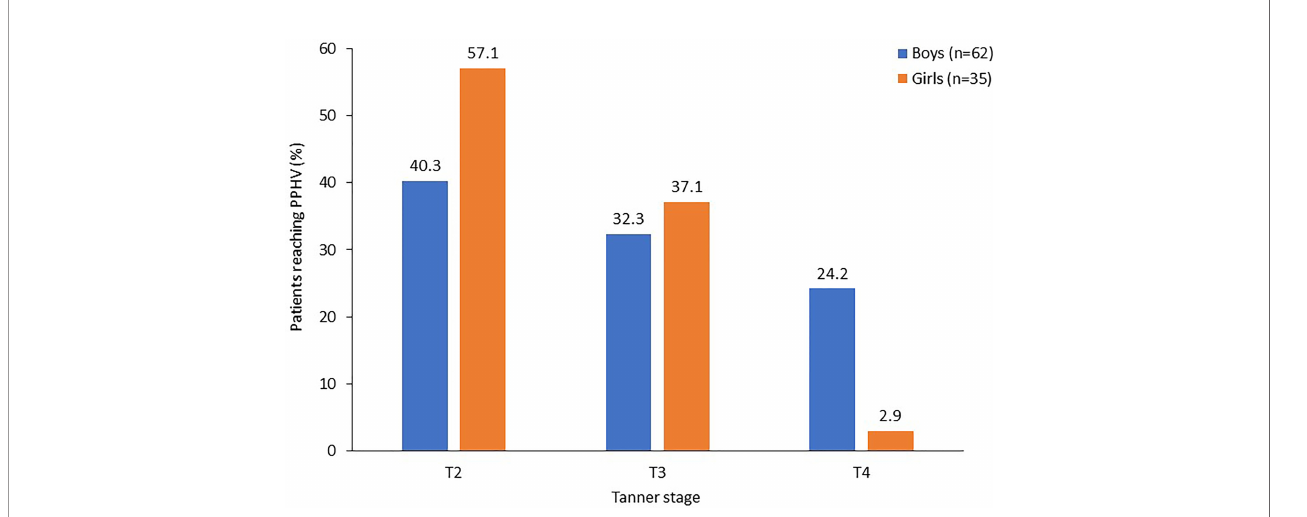
FIGURE 3 | Pubertal stage at pubertal peak height velocity in children receiving rhIGF-1 for SPIGFD with growth failure. Percentage of patients who started puberty with available data on PPHV, and stage at which PPHV occurred. Percentages for each gender do not add up to 100% as Tanner stage 5 has been omitted from this fi gure. PPHV, pubertal peak height velocity; SPIGFD, severe primary insulin-like growth factor-1 de fi